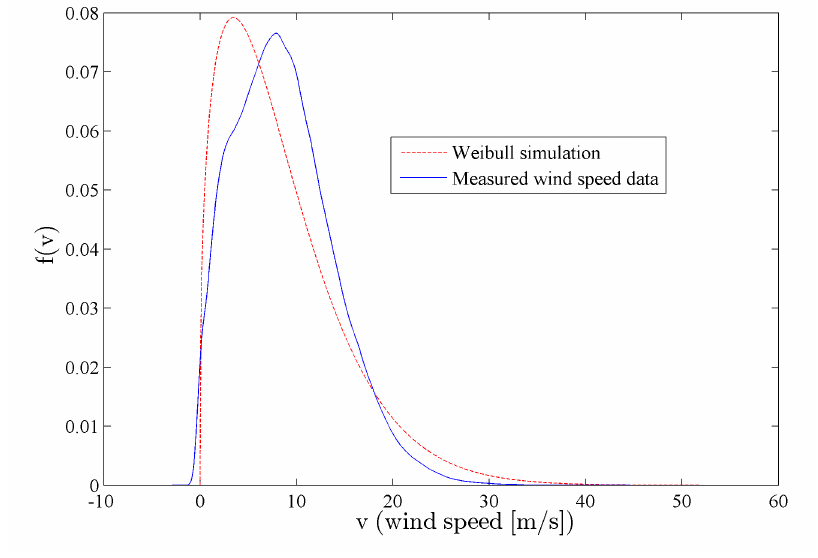
Figure 8. PDF of the Weibull distribution and measured wind speed data.